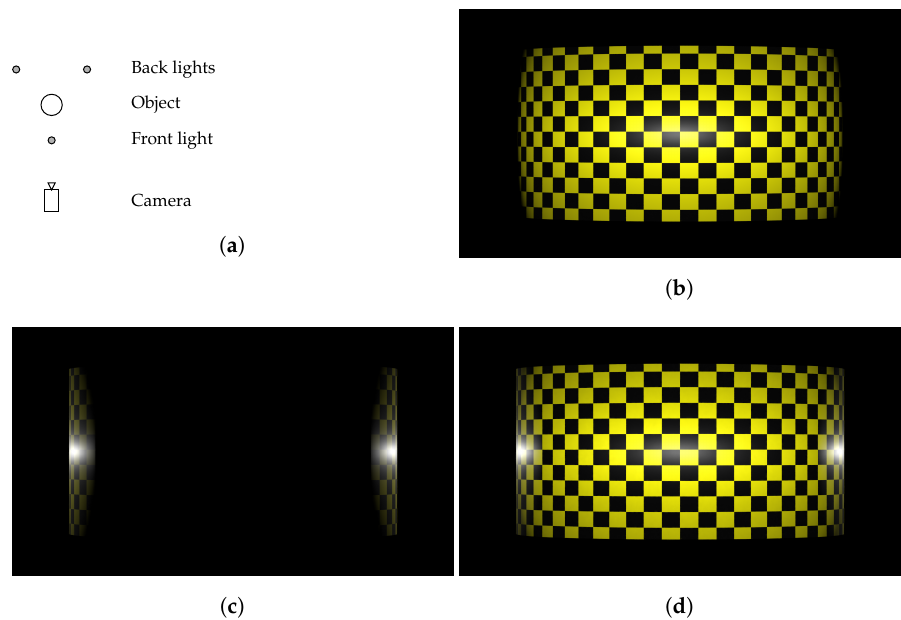
Figure 3. Which cylinder is wider? The light sources behind the cylinder highlight the edges, thereby making the cylinder optically wider. ( a ) Setup, ( b ) frontal lighting, ( c ) back lighting and ( d ) frontal and back